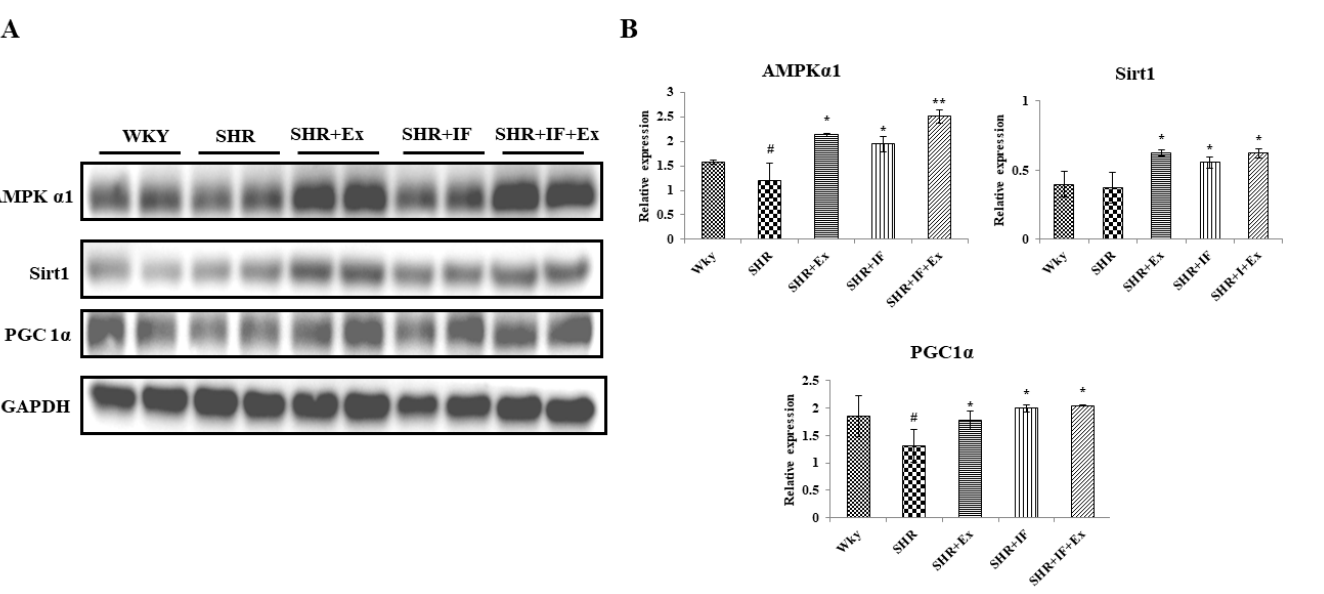
Figure 9. IF treatment combined with exercise training alleviates hypertension by modulating AMPK α 1, SIRT1, and PGC1 α signaling pathways. ( A ) Expression of AMP-activated protein kinase α 1, sirtuin 1, and peroxisome proliferator-activated receptor gamma coactivator 1-alpha proteins. ( B ) Densitometric analysis of relative protein expression, normalized with internal control GAPDH. n = 8, # p < 0.01 compared to WKY, * p < 0.05 and ** p < 0.01 compared to SHR.